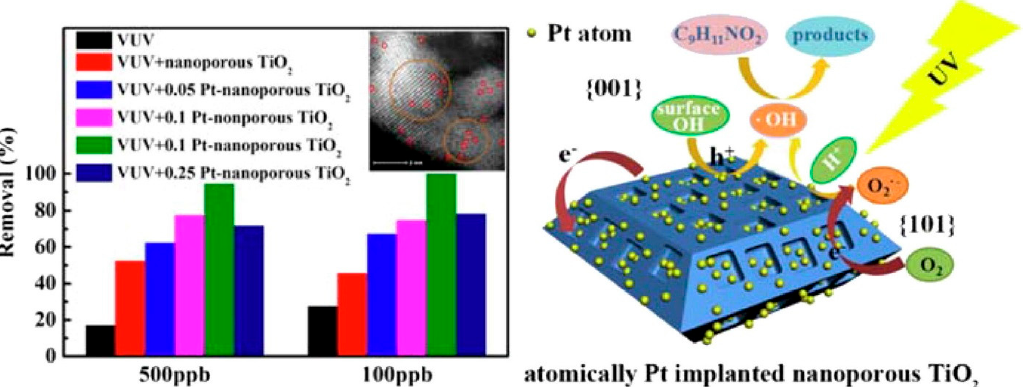
Figure 12. ( a ) Photocatalytic degradation of dye activity within 0.5 min ( b ) Photocatalytic mechanism atomically Pt-nanoporous TiO 2 with exposed {001} facets under UV irradiation. Reprinted with permission from [194].